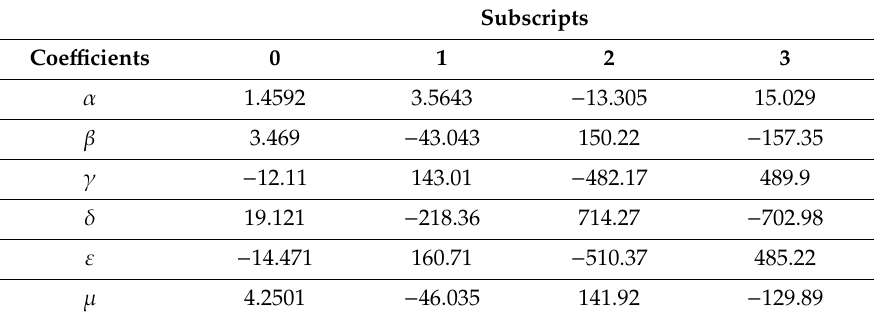
Table 6. Table of coe ffi cients for normalized M-factor, internal surface